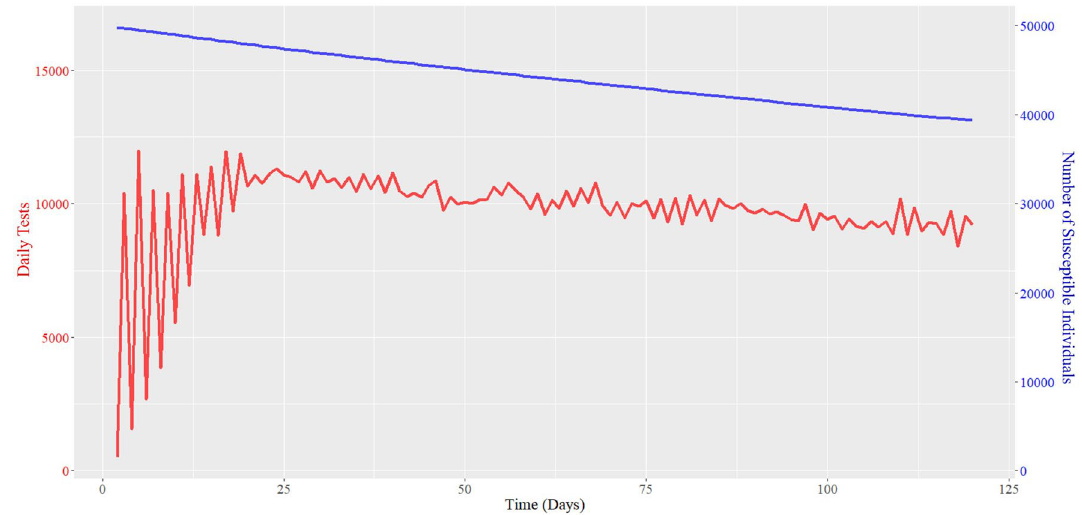
Figure 5. Adaptive testing outcome with maximum test capacity of 15, 000 (average daily tests: 9688, maximum daily tests: 11,998, f S : 0.887 .